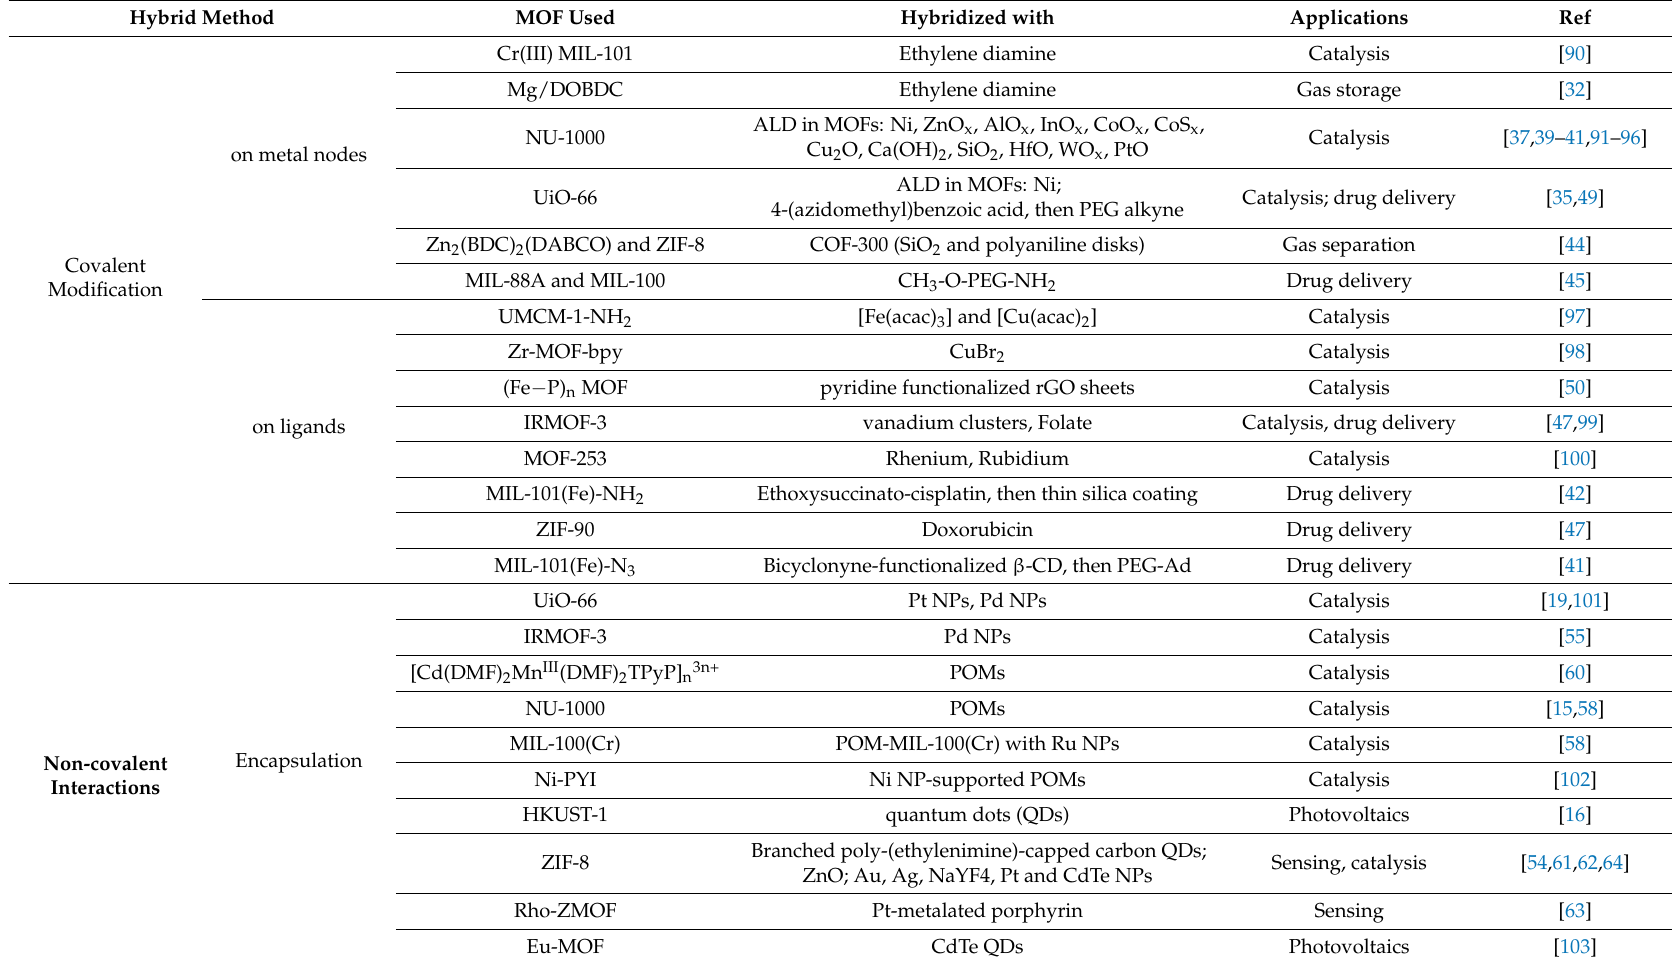
Table 1. A summary of reported MOF hybrids and their